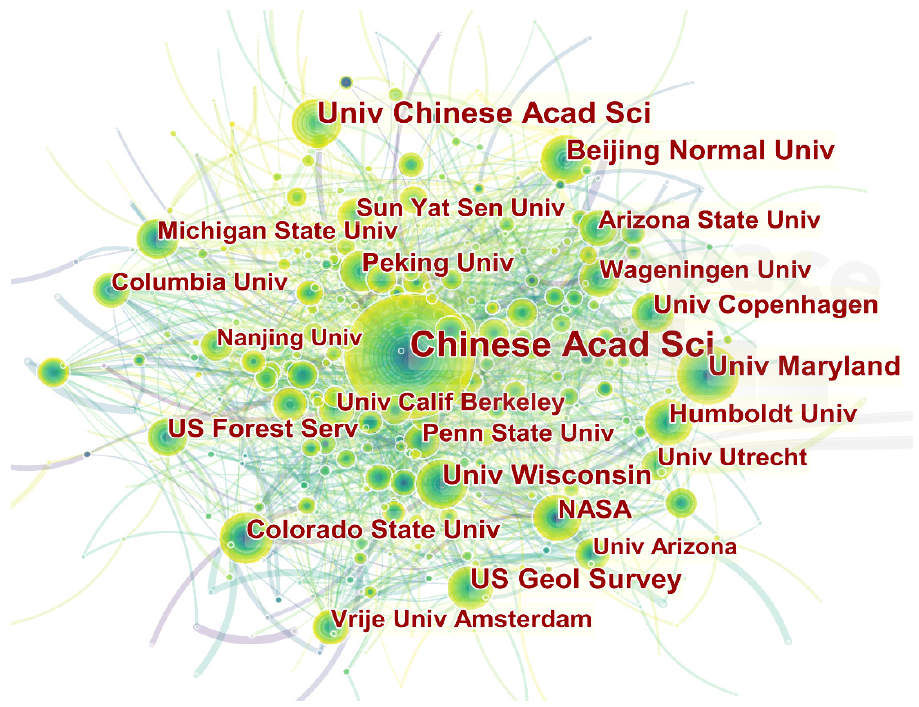
Figure 4. Institutional cooperation network map of LUT research.